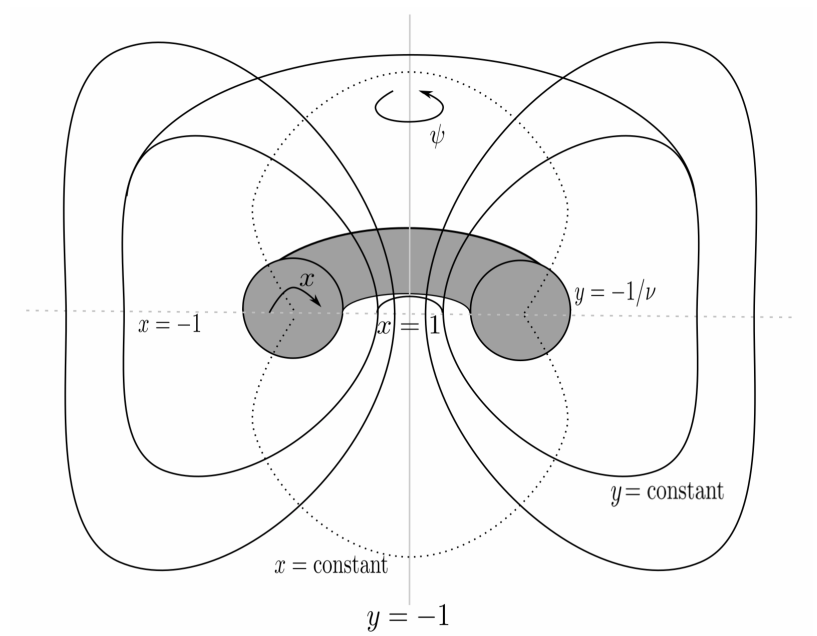
Figure 1 . Sketch of a section of constant t and ϕ of the black ring (figure based on ref. [37]). The disc at x = 1 and infinite annulus at x = − 1 are the axes (fixed points) of ∂ ϕ , while the axis of the ring is at y = − 1 (fixed points of ∂ ψ ). Surfaces of constant y have topology S 1 × S 2 . y = − 1 /ν corresponds to the horizon (shaded surface) while surfaces of constant y ∈ ( − 1 /ν, − 1) are fatter rings containing the horizon in their